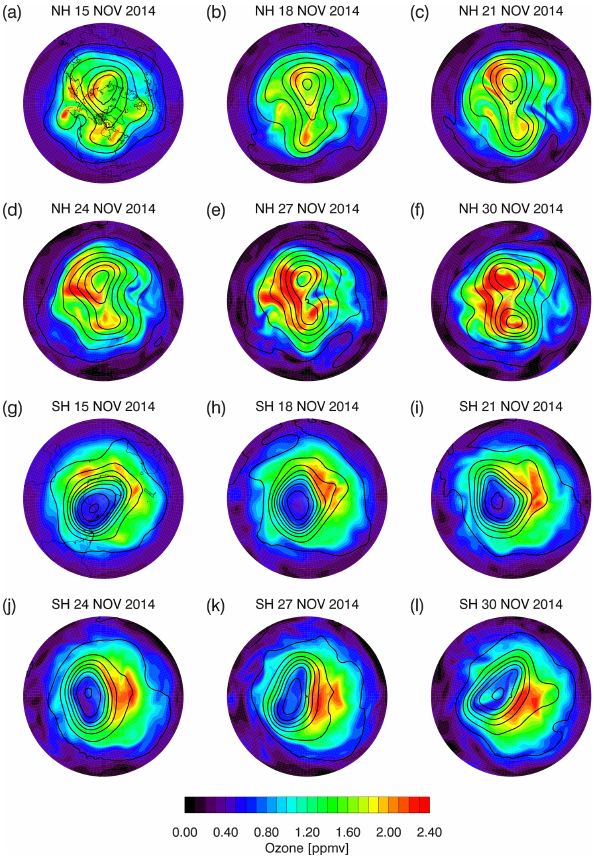
Figure 6. Maps of ozone (ppmv) (colors) at 10.5hPa ( ∼ 32km) overlaid with geopotential height (black lines) at 200m intervals for 15, 18, 21, 24, 27, and 30 November 2014 (all at 00:00Z). Pan- els (a–f) are NH and (g–l) are SH. Red (blue) contours indicated high (low) ozone values. Continent lines are placed on the maps for 15